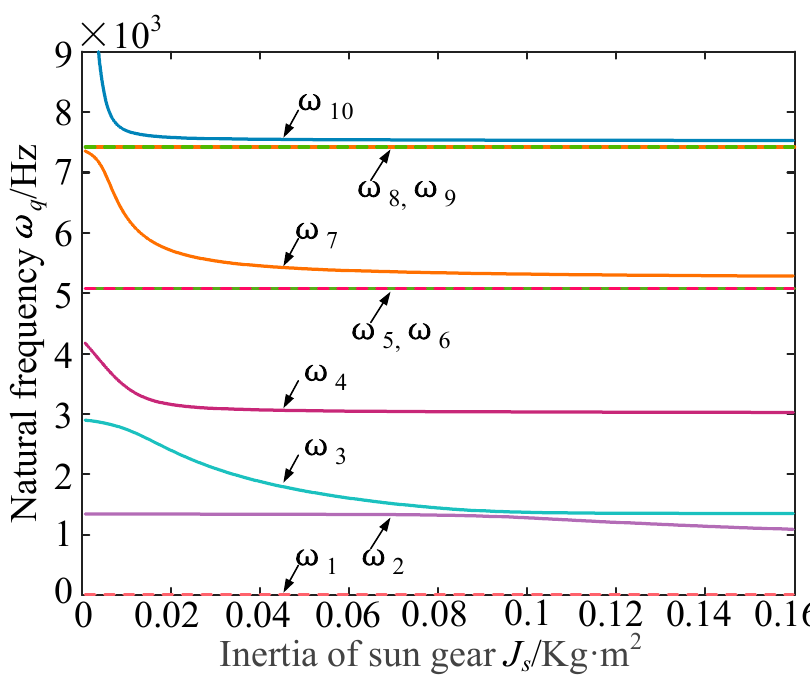
Figure 14. The trajectory of the natural frequency with J s .